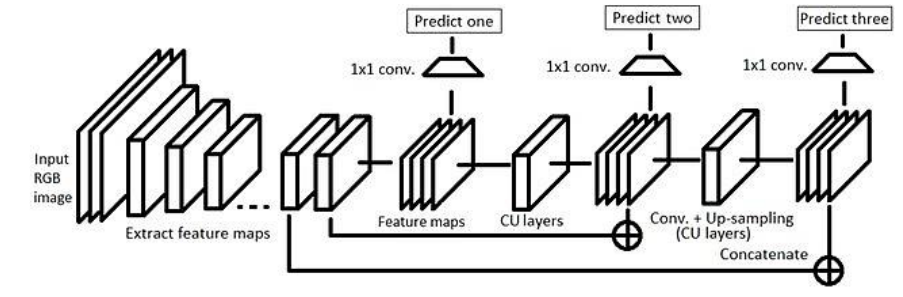
Fig. 4. The structure of the YOLOv3 architecture.